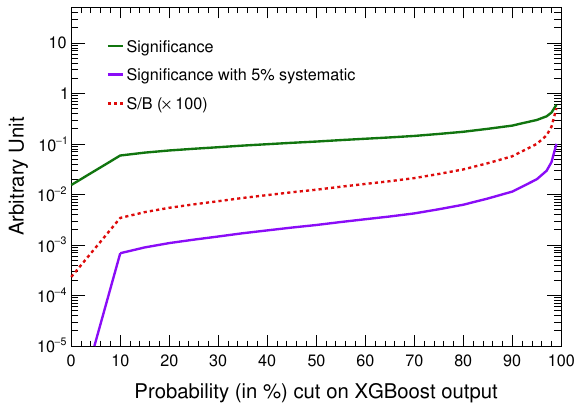
Figure 15 . The variation of significance (with ( 5% ) and without systematic uncertainty) and S/B is shown as a function of the probability cut on the XGBoost output for the b ¯ bµ + µ −